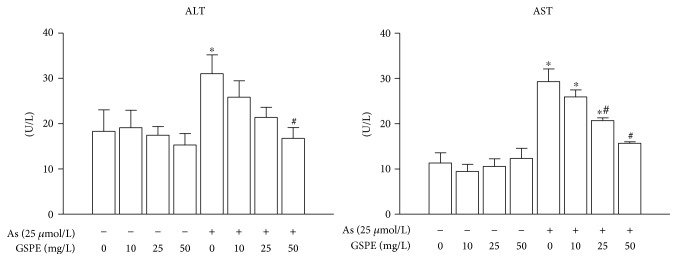
Effects of arsenic and/or grape seed procyanidin extract on liver function after 24 h (mean ± SD, n = 3). ∗Versus the control group, P < 0.05; #versus the arsenic group, P < 0.05. ALT and AST activities in the arsenic group were markedly higher than those in the control group. Arsenic + GSPE treatment decreased the activities of ALT and AST compared with the arsenic group.